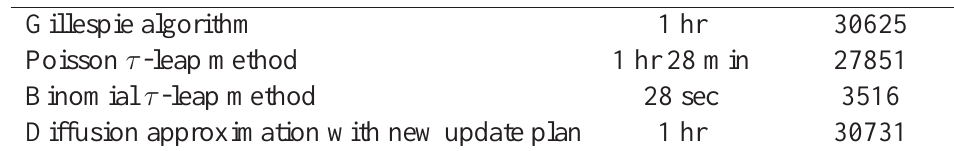
Table 1: Comparison of computational times (2st column) and total number of iterations (3rd column) of the Gillespie algorithm, the Poisson τ -leap method, the Binomial τ -leap method, and the diffusion approximation with new update plan, respectively under the first scenario and t = 5